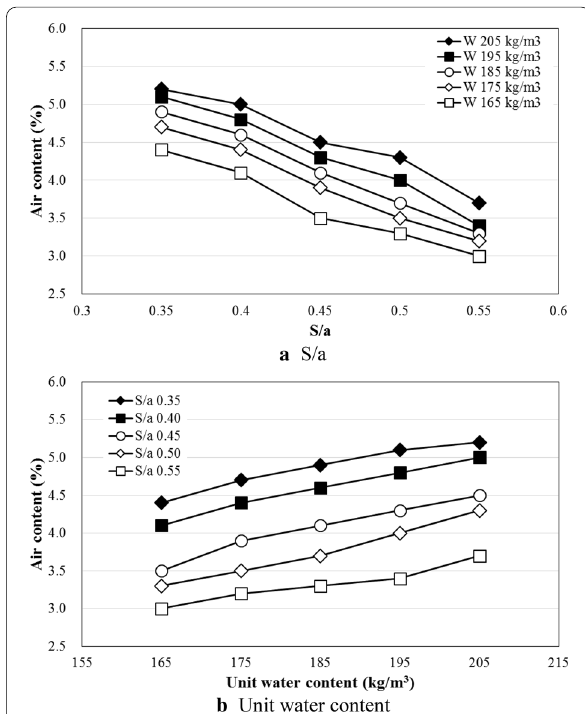
Fig. 4 Effects of S/a and unit water content on slump of normal concrete mixtures.